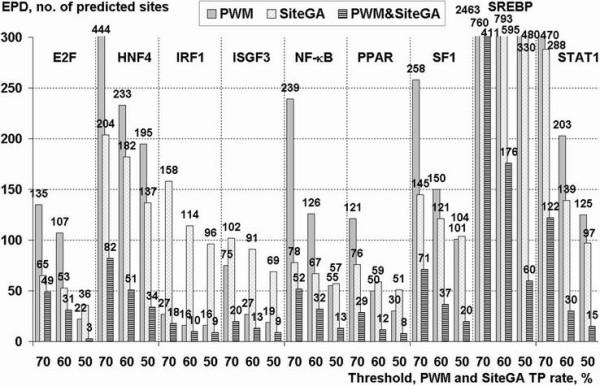
Analysis of TFBSs predictions in EPD promoters by SiteGA, PWMs and combined PWM & SiteGA approach. X-axis – TF types and stringencies in terms of fixed TP rates (50, 60 and 70% for SiteGA and PWMs); Y-axis – no. of predicted sites (data labels are marked for each point). Combined approach implied that both PWM and SiteGA models recognized a potential site.